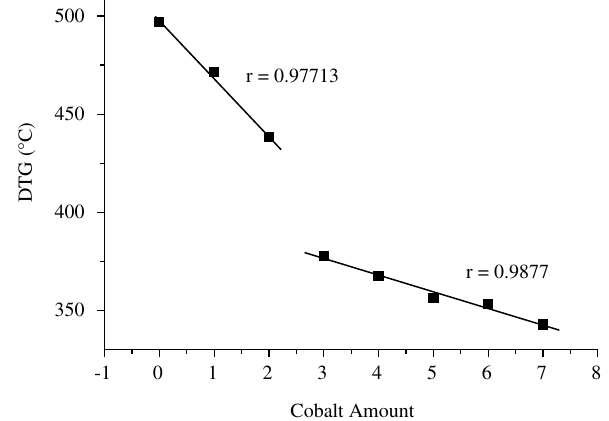
Figure 4. X-ray diffraction of the sample Zn perature.